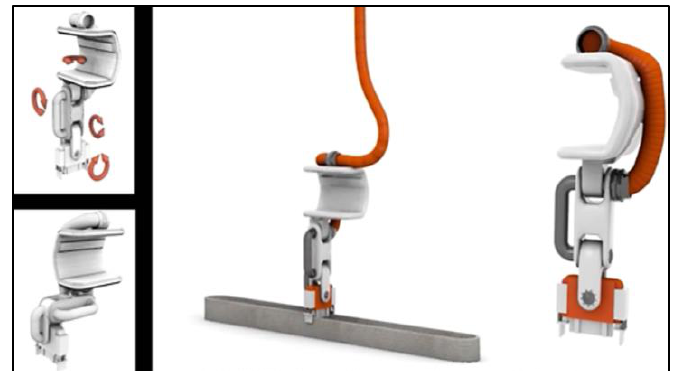
Figure 2. Outline of CC machine nozzle equipped with 4 mobile axes